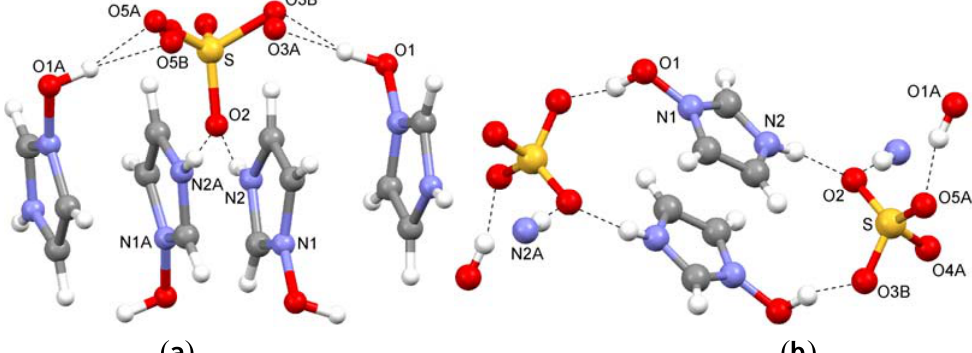
Figure 4. ( a ) Hydrogen bonding and ( b ) cyclic arrangement of the ions in bis(1-hydroxyimidazolium) sulfate ( 4